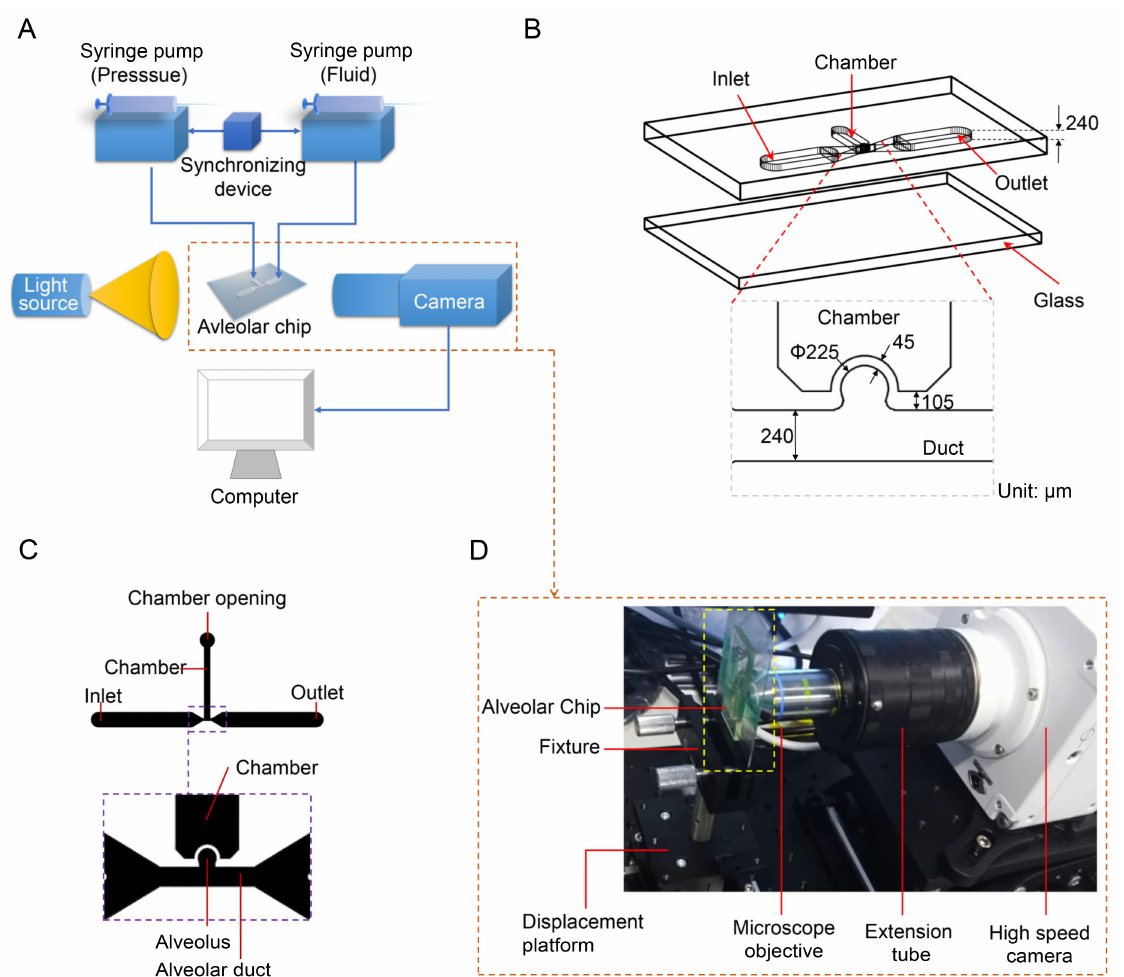
Figure 1. Model of the alveolus chip and experimental system. ( A ) Schematic diagram of experimental system. ( B ) Schematic diagram of the alveolar chip. ( C ) CAD drawing of the alveolar chip. ( D ) Photo of optical observation system. Figure ( C ) is adapted from the work of Lv et al. [38]. [Original citation]—Reproduced by permission of The Royal Society of